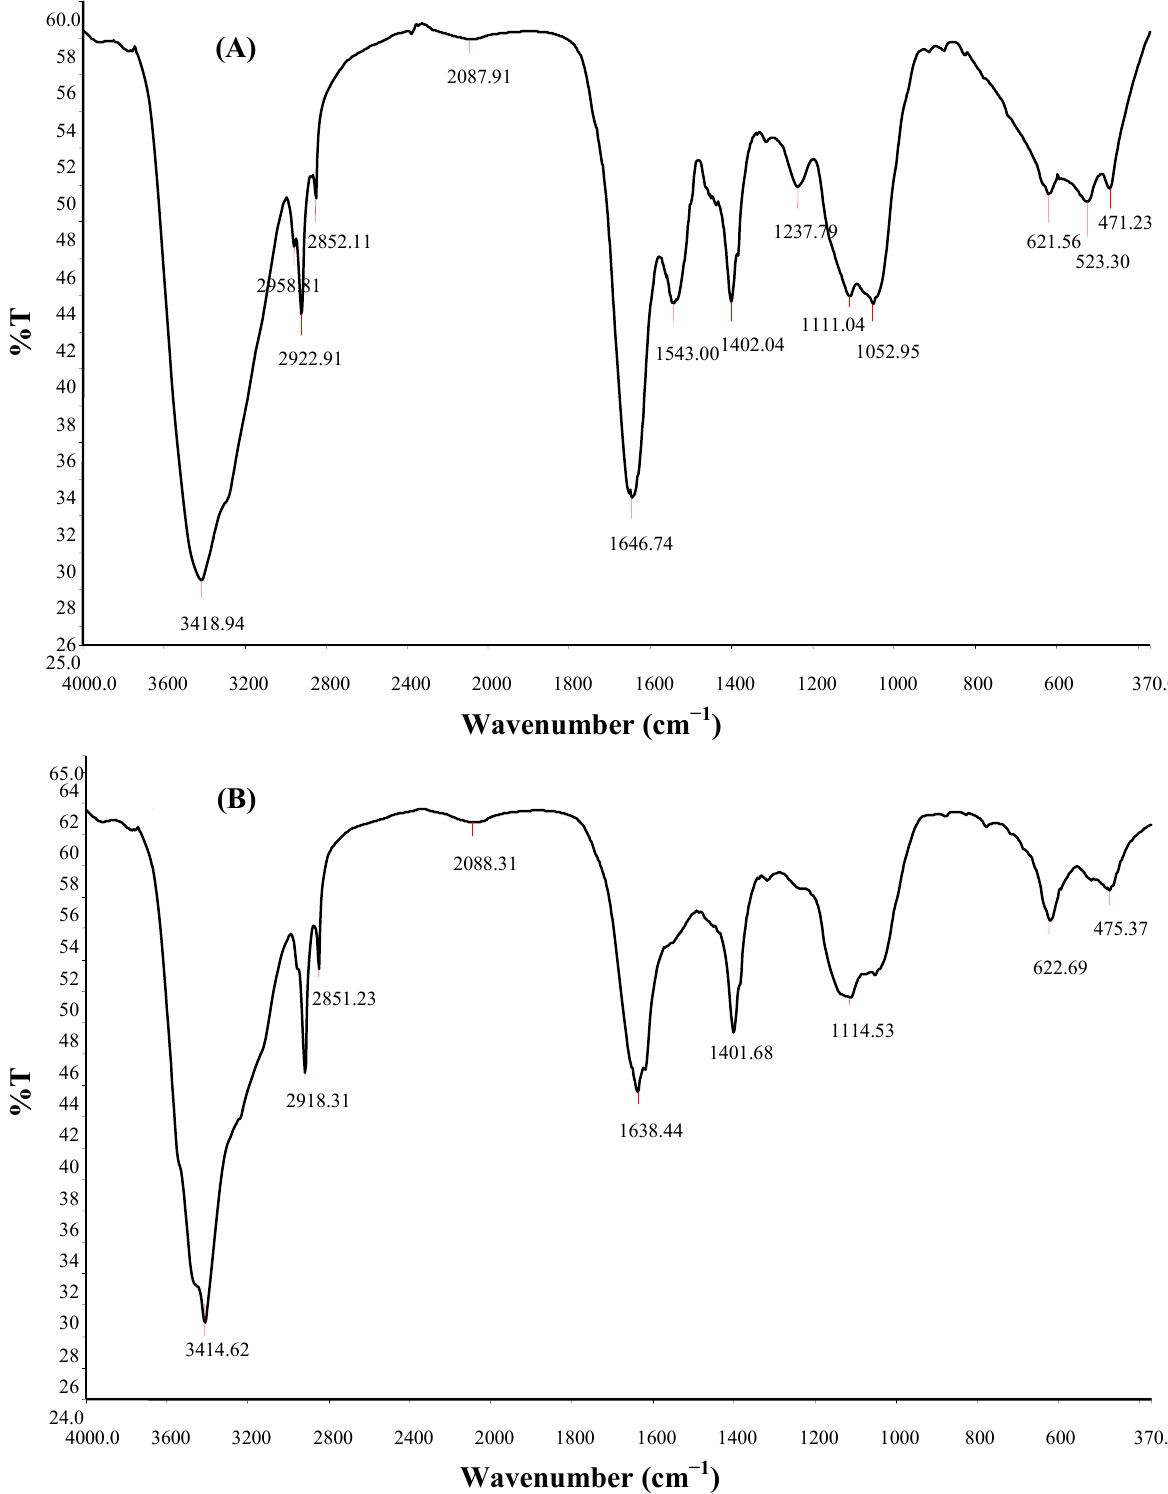
Figure 5. Fourier transform infrared (FTIR) spectra of purified bioflocculant from Brachybacterium sp. UFH. ( A ) partial purified bioflocculant (PPB); ( B ) cetylpyridinium chloride purified bioflocculant